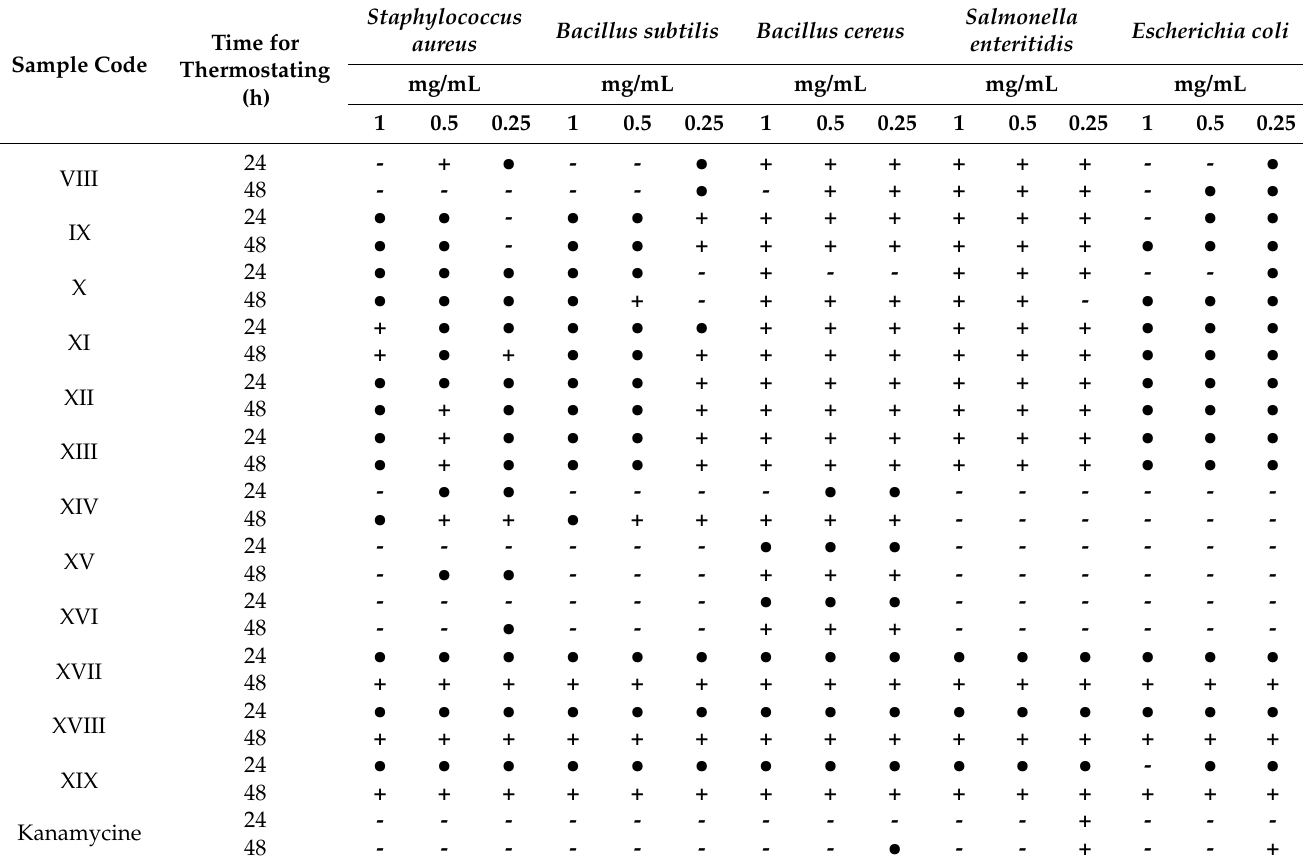
Table 2. Antibacterial spectra of 1,3,4-thiadiazoles and 1,2,4- triazoles.